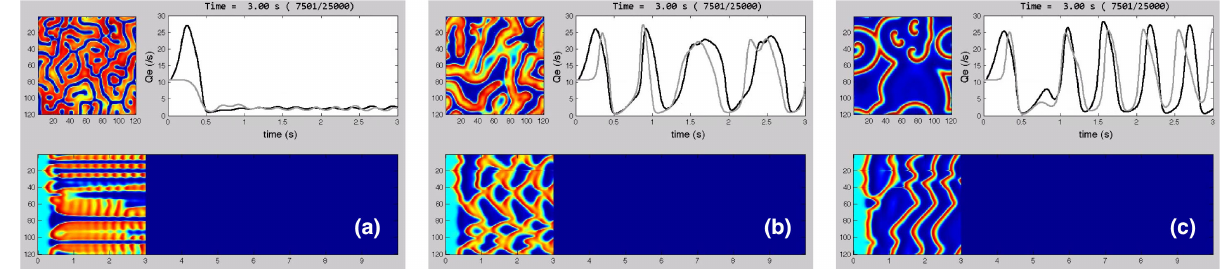
VIDEO 1. Three movies showing the effect of inhibitory diffusion D 2 on cortical dynamics. (a) D 2 ¼ 0 : 68 cm 2 ; (b) D 2 ¼ 0 : 40 cm 2 ; (c) D 2 ¼ 0 : 30 cm 2 . Each simulation is started at the (cid:13) i ¼ 1 : 0 high-firing awake state of Fig. 3, and runs for 10 s of simulated time. (See Ref. [42] for further details.)